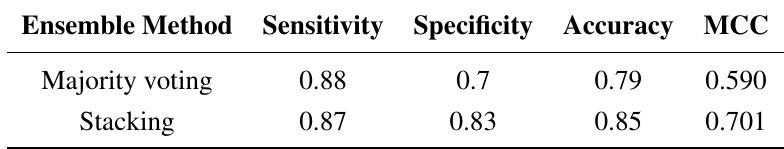
Table 3. Performance of the stacking-based ensemble learning and majority voting-based strategy.